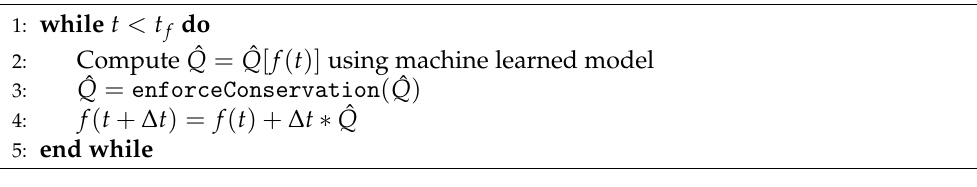
Algorithm 1 Solve 0-dimensional